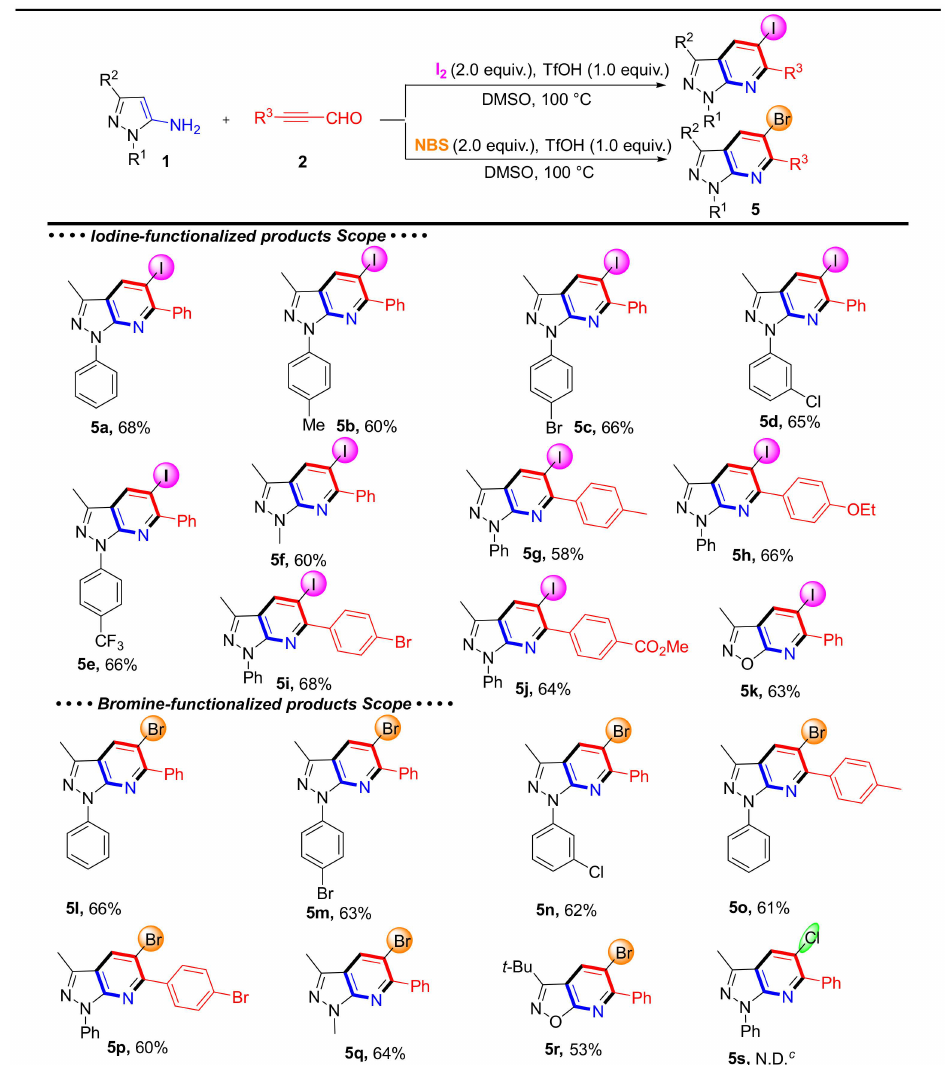
Scheme 4. The substrate scope and Isolated yield of halogen-functionalized products.